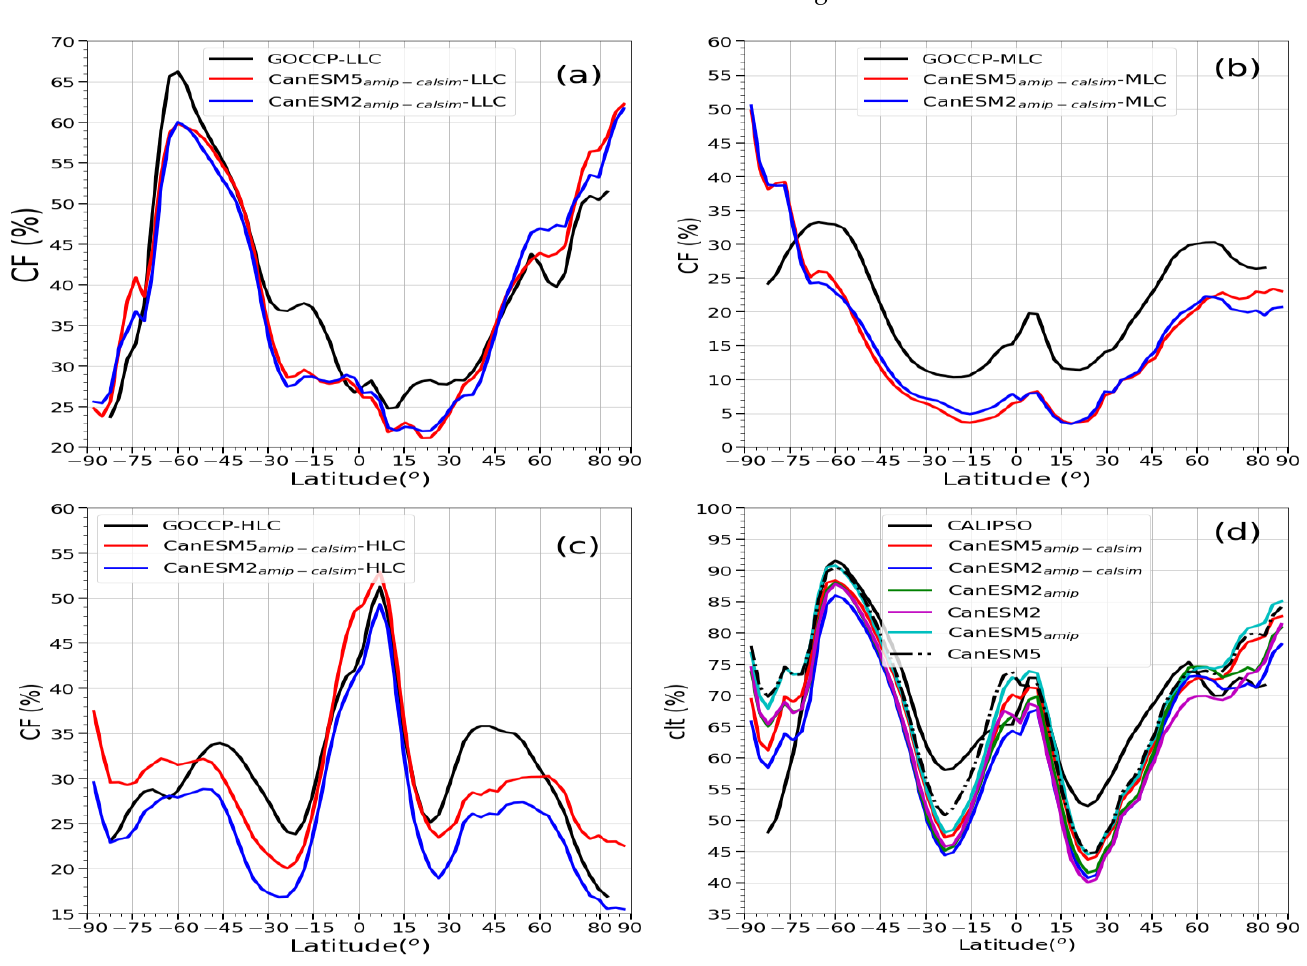
Figure 6. Annually and zonal averaged low-level cloud (LLC) ( a ), mid-level cloud (MLC) ( b ), high level cloud (HLC) ( c ), and total cloud cover ( d ) based on the models, GOCCP.